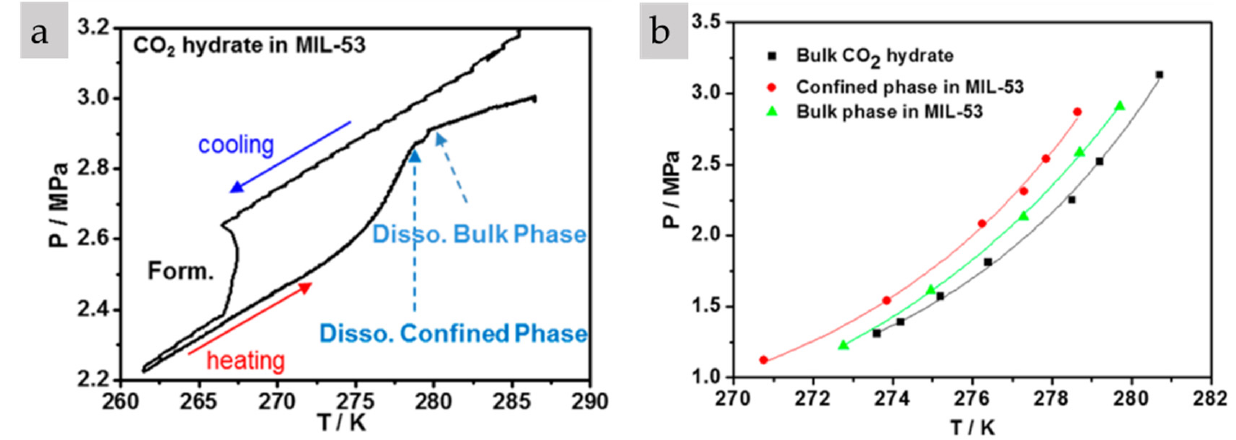
Figure 14. CO 2 hydrate phase diagram in the presence of water ‐ saturated MIL ‐ 53 [76]: ( a ) Cooling and heating cycle; ( b ) Thermodynamic stability curve (Reproduced from [76], copyright (2015), with written permission from the American Chemical Society).